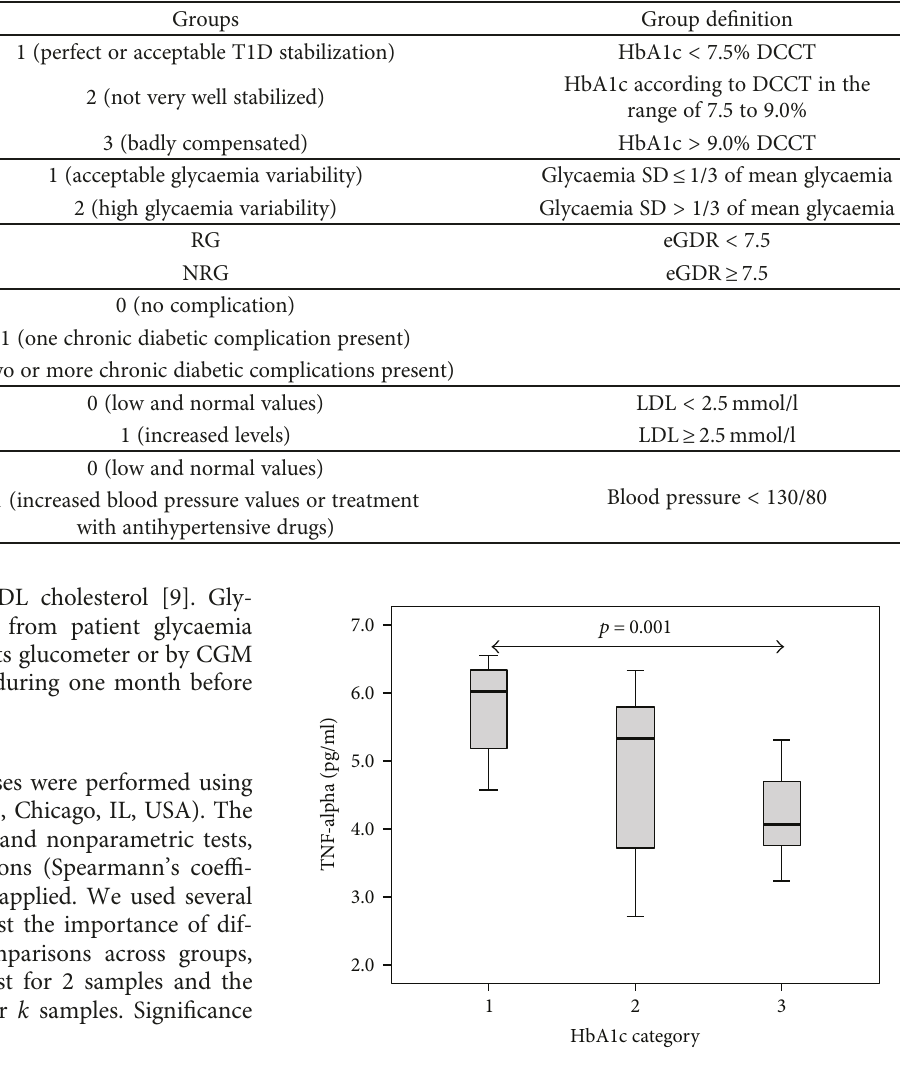
Figure 1: In fl ammatory cytokines and HbA1c category. Patients with the worst diabetes stabilization (evaluated according to glycosylated haemoglobin HbA1c) had surprisingly the lowest level of proin fl ammatory cytokine TNF-alpha. There was a signi fi cant di ff erence between this subgroup (marked as category 3) and the subgroup of patients with the best HbA1c (marked as category